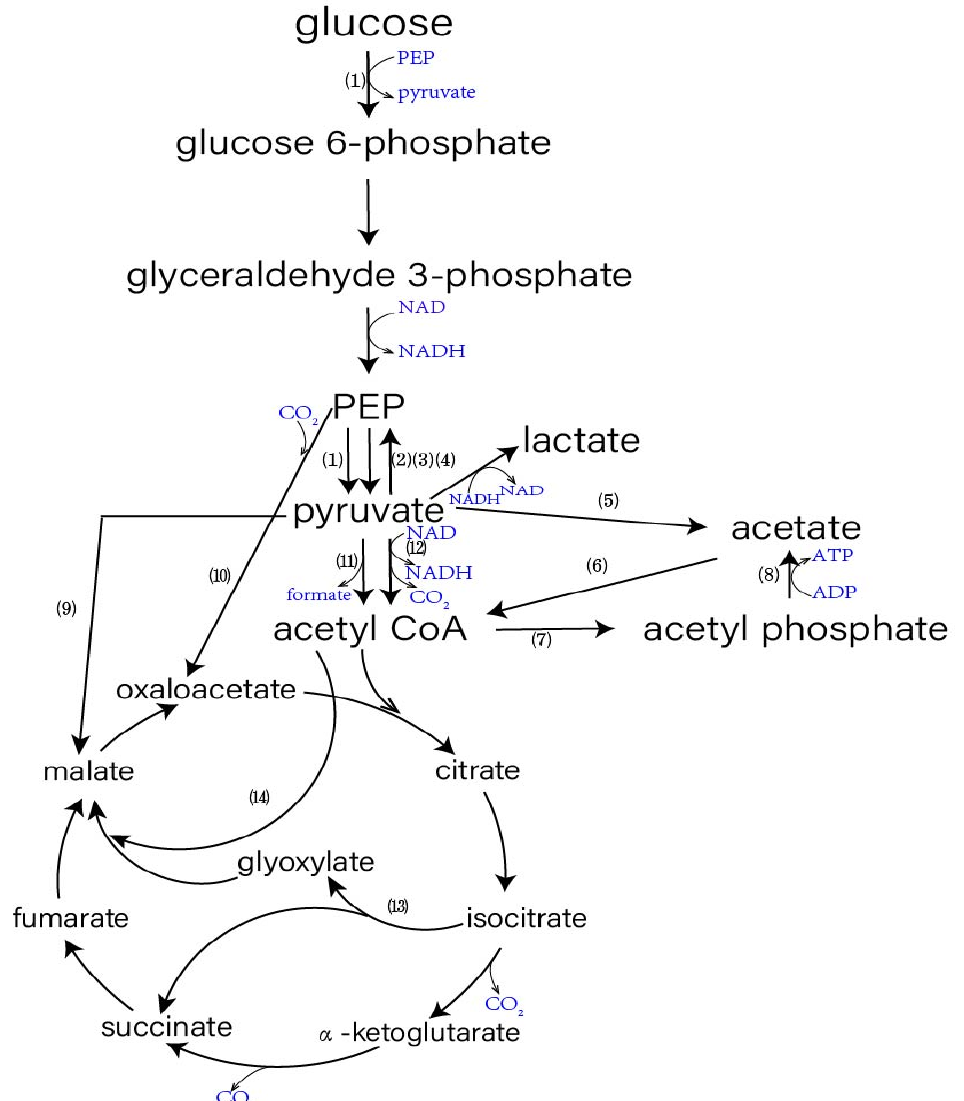
Figure 2. Metabolic pathway of E. coli related to pyruvate production. (1) phosphotransferase system (PTS). (2) pyruvate oxidase (PYK). (3) PEP synthase (PPS). (4) lactate dehydrogenase (LDH). (5) pyruvate oxidase (PoxB). (6) acetyl CoA synthetase (ACS). (7) phosphotransacetylase. (8) acetate kinase. (9) malic enzyme (ME). (10) PEP carboxylase (PPC). (11) pyruvate formate-lyase (PFL). (12) pyruvate dehydrogenase complex (PDH). (13) isocitrate lyase. (14) malate synthase.